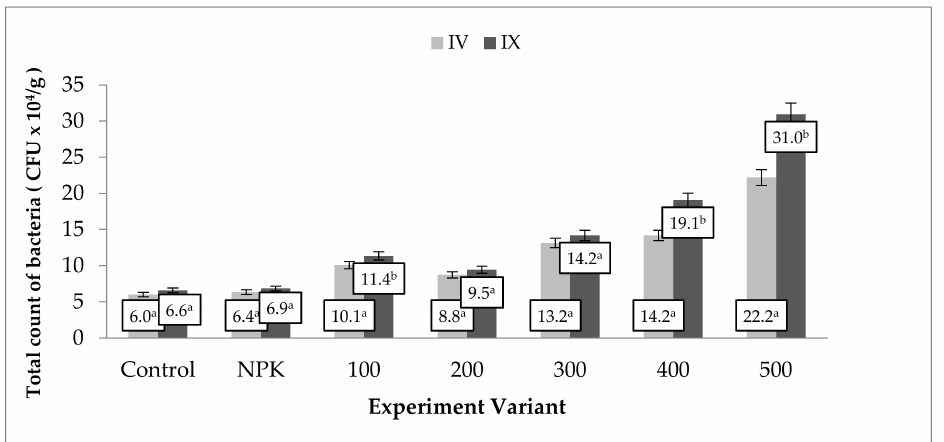
Figure 7. Differences in the number of bacteria (expressed in CFU × 10 4 /g of dry soil) in the podzolic soil in the layer of 0–5 cm after the application of different doses of the ash fertilizer. Treatments not sharing the same letter(s) are statistically significant at p < 0.05 (Tukey’s HSD).